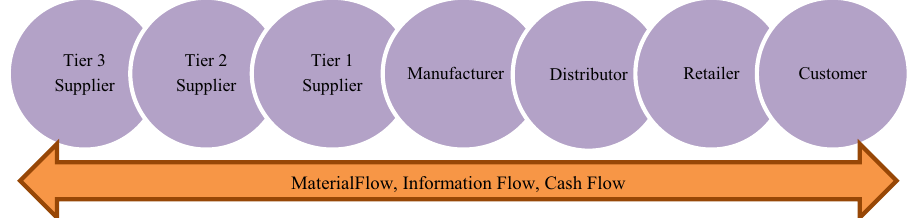
Fig. 1 A generic forward supply chain network